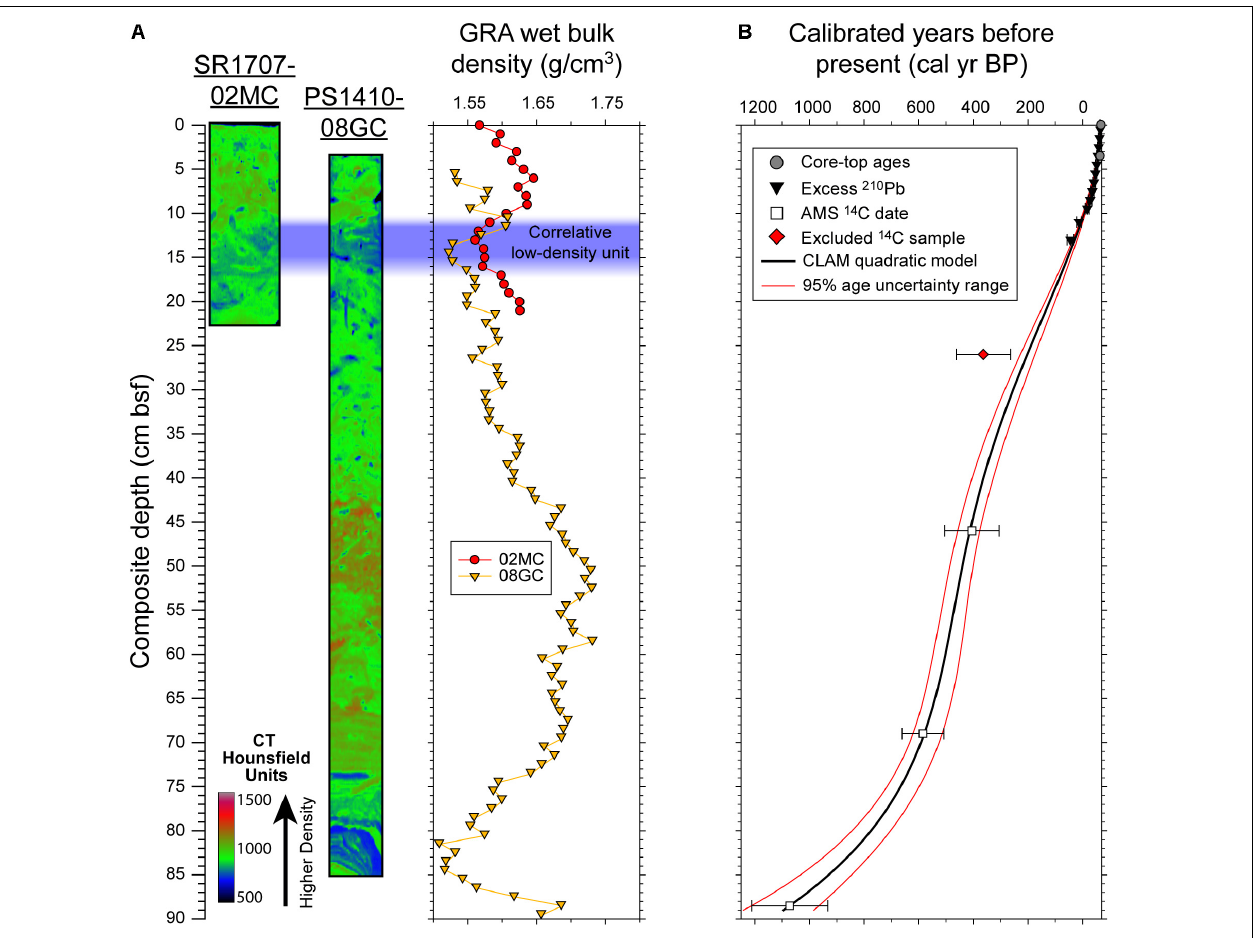
FIGURE 2 | (A) Stratigraphic correlation of SR1707-02MC and PS1410-08GC using CT imaging and GRA wet bulk density. The presence of a low-density horizon allows for the alignment of 08GC to the 02MC datum. (B) CLAM quadratic regression age model and 95% uncertainty range. Ages are expressed as years Before Present (BP) where “present” is referenced to 1950